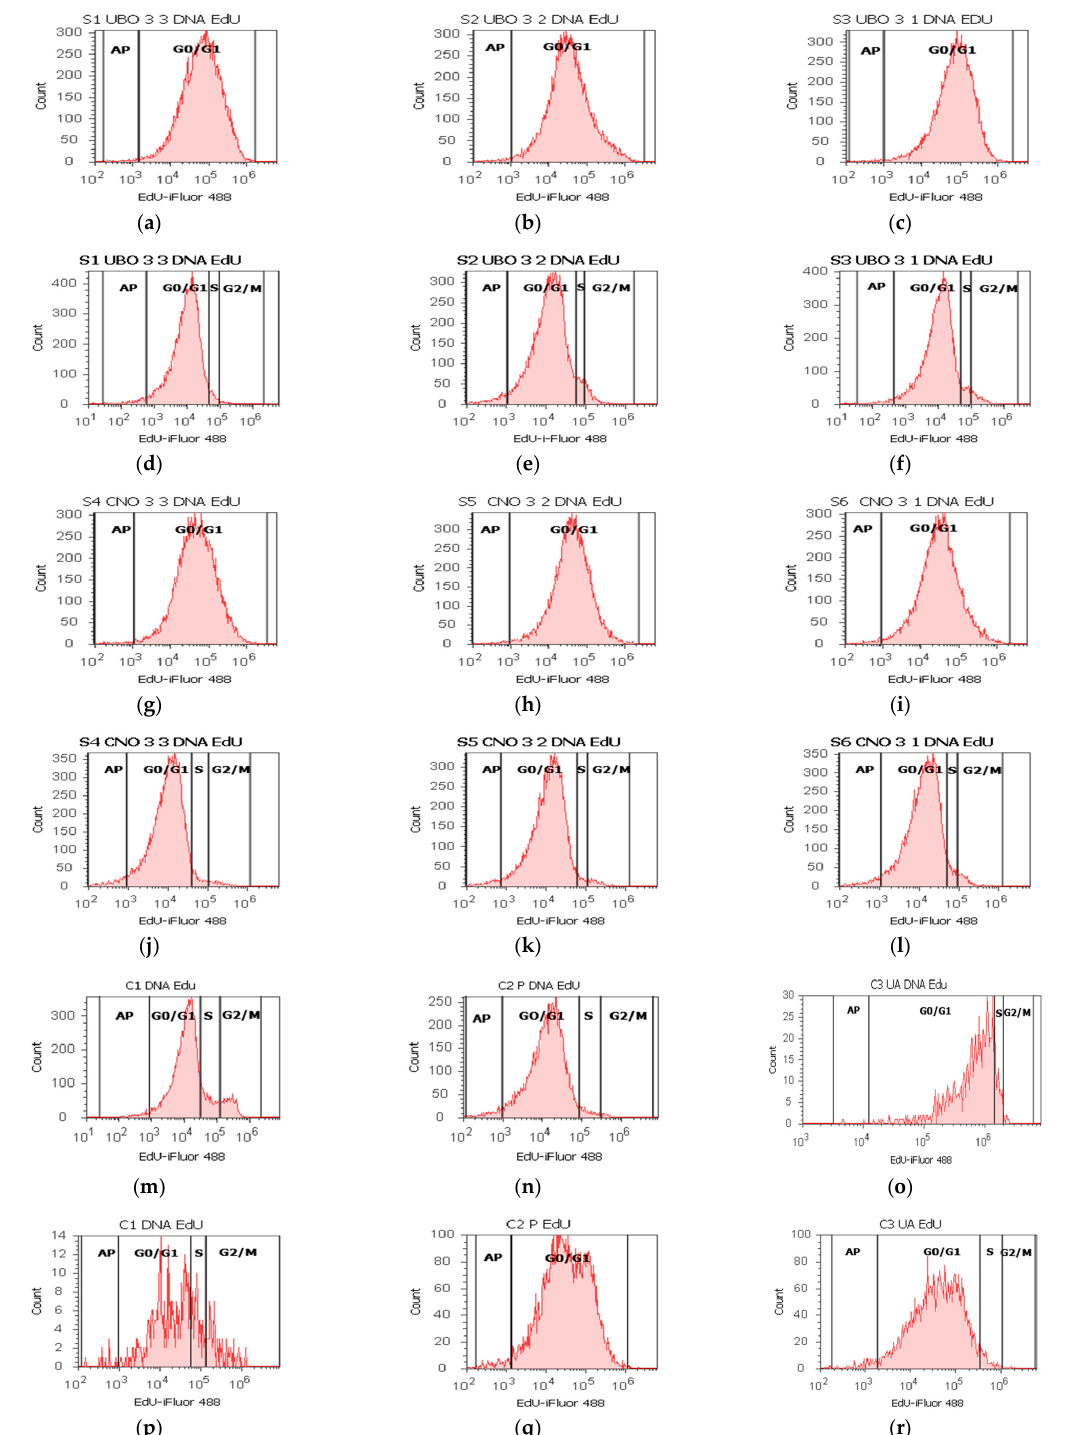
Figure 9. DNA synthesis and fragmentation in blood cells ( a – c , g – i , m – o ) and CLS-354 tumor cells ( d – f , j – l , p – r ) after 24 h exposure to different concentrations [3:3; 3:2; 3:1] of U. barbata extract in canola oil (UBO); ( a – f ) and canola oil (CNO) ( g – l ) compared to C1, C2P, and C3UA controls ( m – r